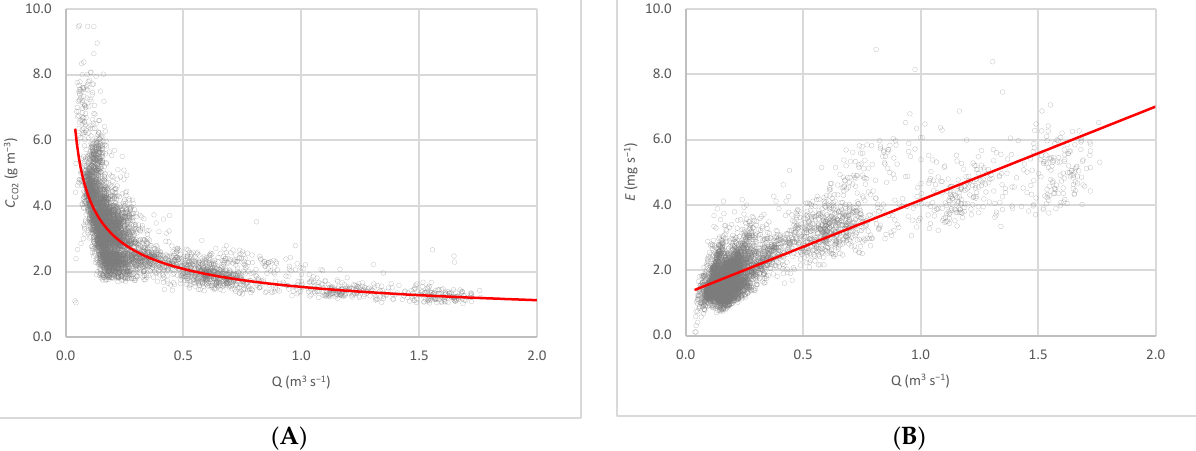
Figure 5. Correlation between ( A ) CO 2 concentration, C CO2 (g m − 3 ), – potential approximation, and ( B ) CO 2 emission per animal, E CO2 (mg s − 1 ), – linear relationship, and ventilation flow, Q (m 3 s − 1 ) ◦ measured values throughout the cycle.